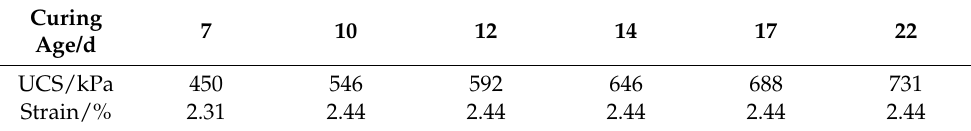
Table 6. Peak UCS and strain of PCC at failure point.